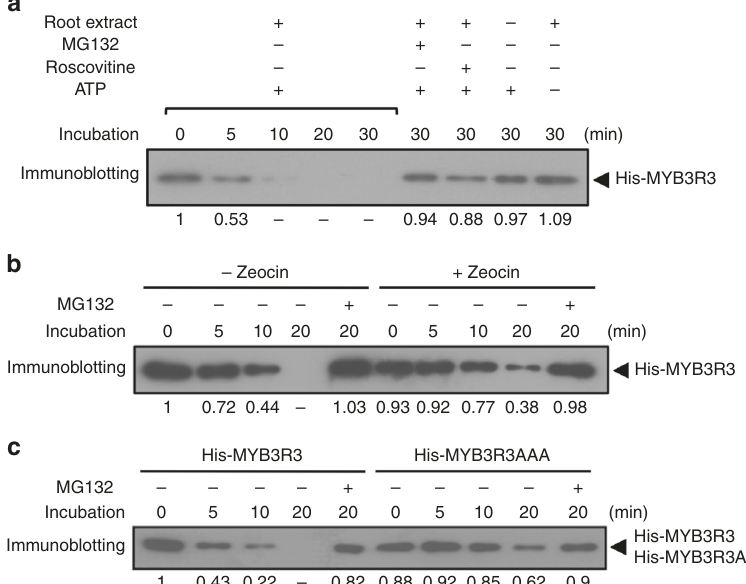
Fig. 4 In vitro degradation assay of MYB3R3. Recombinant His-MYB3R3 protein was incubated with or without root extracts from 7-day-old WT seedlings, and His-MYB3R3 was immunoblotted with anti-His antibodies. a Protein mixtures were incubated in the presence or absence of 50 µ M MG132, 25 µ M roscovitine and/or 10 mM ATP for the indicated times. b Total protein was extracted from 7-day-old WT roots treated with or without 2 μ M zeocin for 24 h. Protein mixtures were incubated in the presence or absence of 50 µ M MG132 for the indicated times. c Recombinant His-MYB3R3 or His-MYB3R3AAA proteins were incubated with root extracts in the presence or absence of 50 µ M MG132 for the indicated times. Relative levels of His-MYB3R3 and His-MYB3R3AAA are expressed as the fold change, normalized with respect to the band of recombinant proteins visualized by CBB